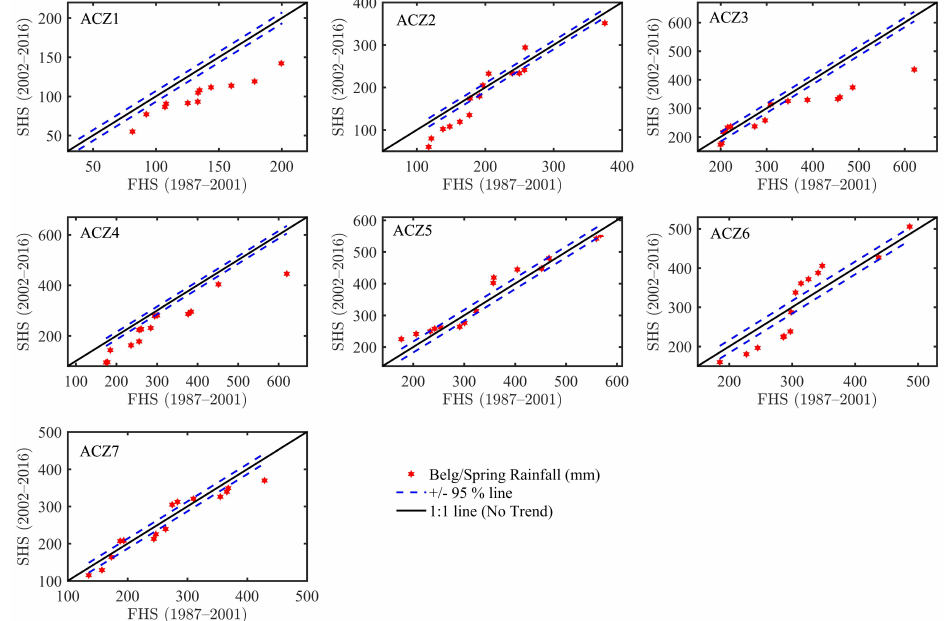
Figure 8. Belg/Spring rainfall trend using the ITA